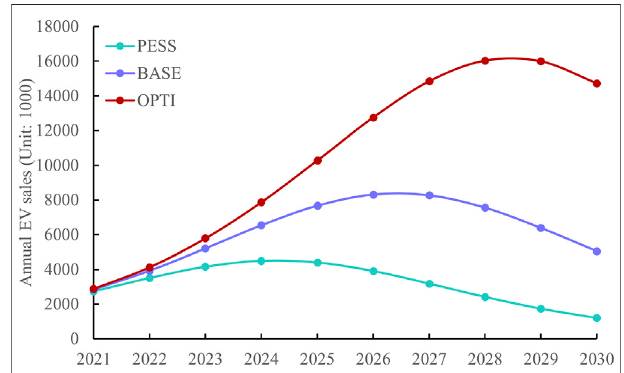
FIGURE 3 | Annual EV sales forecast in China until